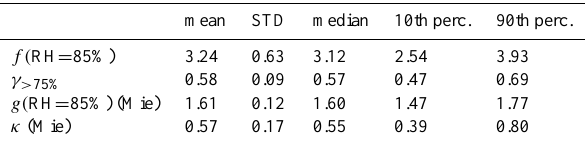
Table 1. Campaign mean, standard deviation (STD), and percentile values of the scattering enhancement factor f ( RH = 85%), its fit parameter γ > 75% (both at λ = 550nm), the apparent hygroscopic growth factor g( RH = 85%), and its κ value (both derived via Mie theory as described in Sect. 3.2).